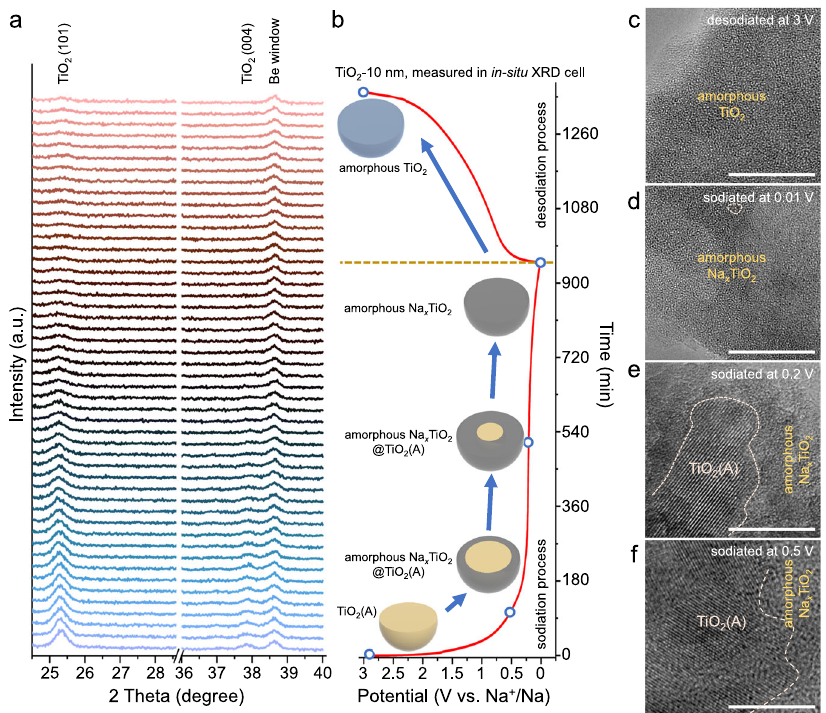
Fig. 2 | Structure evolution of TiO 2 -10nm upon sodiation and desodiation. In- situXRDpatterns( a )andcorrespondinginitialsodiationanddesodiationcurvesat 0.03Ag − 1 ( b ) of TiO 2 -10nm. c Ex-situ HRTEM images of TiO 2 -10nm desodiated at